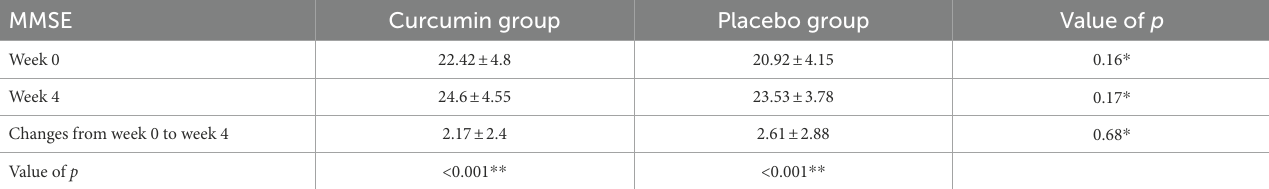
TABLE 2 Changes in MMSE scores of the two groups in 4 weeks.